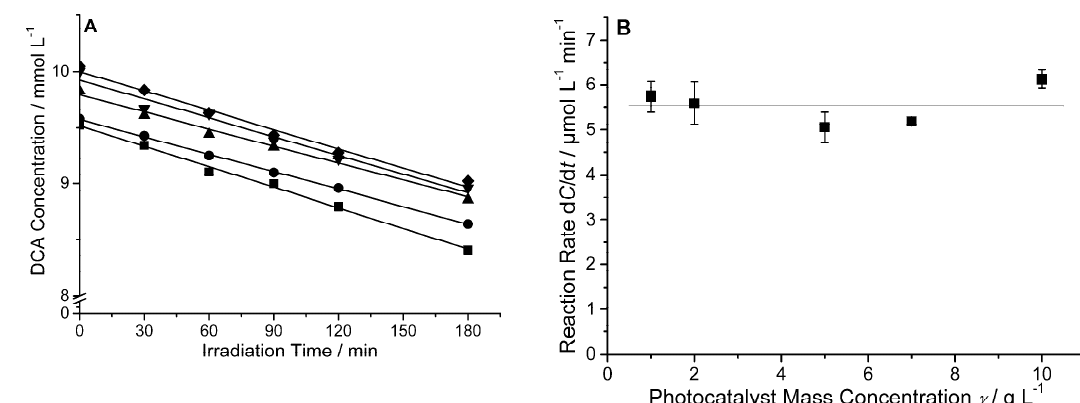
Figure 2. Photocatalytic degradation of dichloroacetic acid (DCA) varying the mass concentration of the photocatalyst Hombikat UV 100: ( A ) Concentration vs. time profiles of suspensions with catalyst concentrations of 10 ( ■ ), 7 ( ● ), 5 ( ▲ ), 2 ( ▼ ), and 1 g L − ¹ ( ♦ ); ( B ) Reaction rates d C /d t (calculated from the slopes of the plots in ( A )) vs. mass concentration γ . The line in (B) represents the average of the five data points. Experimental conditions: C s = 10 mmol L − ¹, V = 400 mL, photon flux = 10.7 µmol min − ¹, pH 3, 10 mmol L − ¹ KNO 3 , air saturated, ambient temperature.